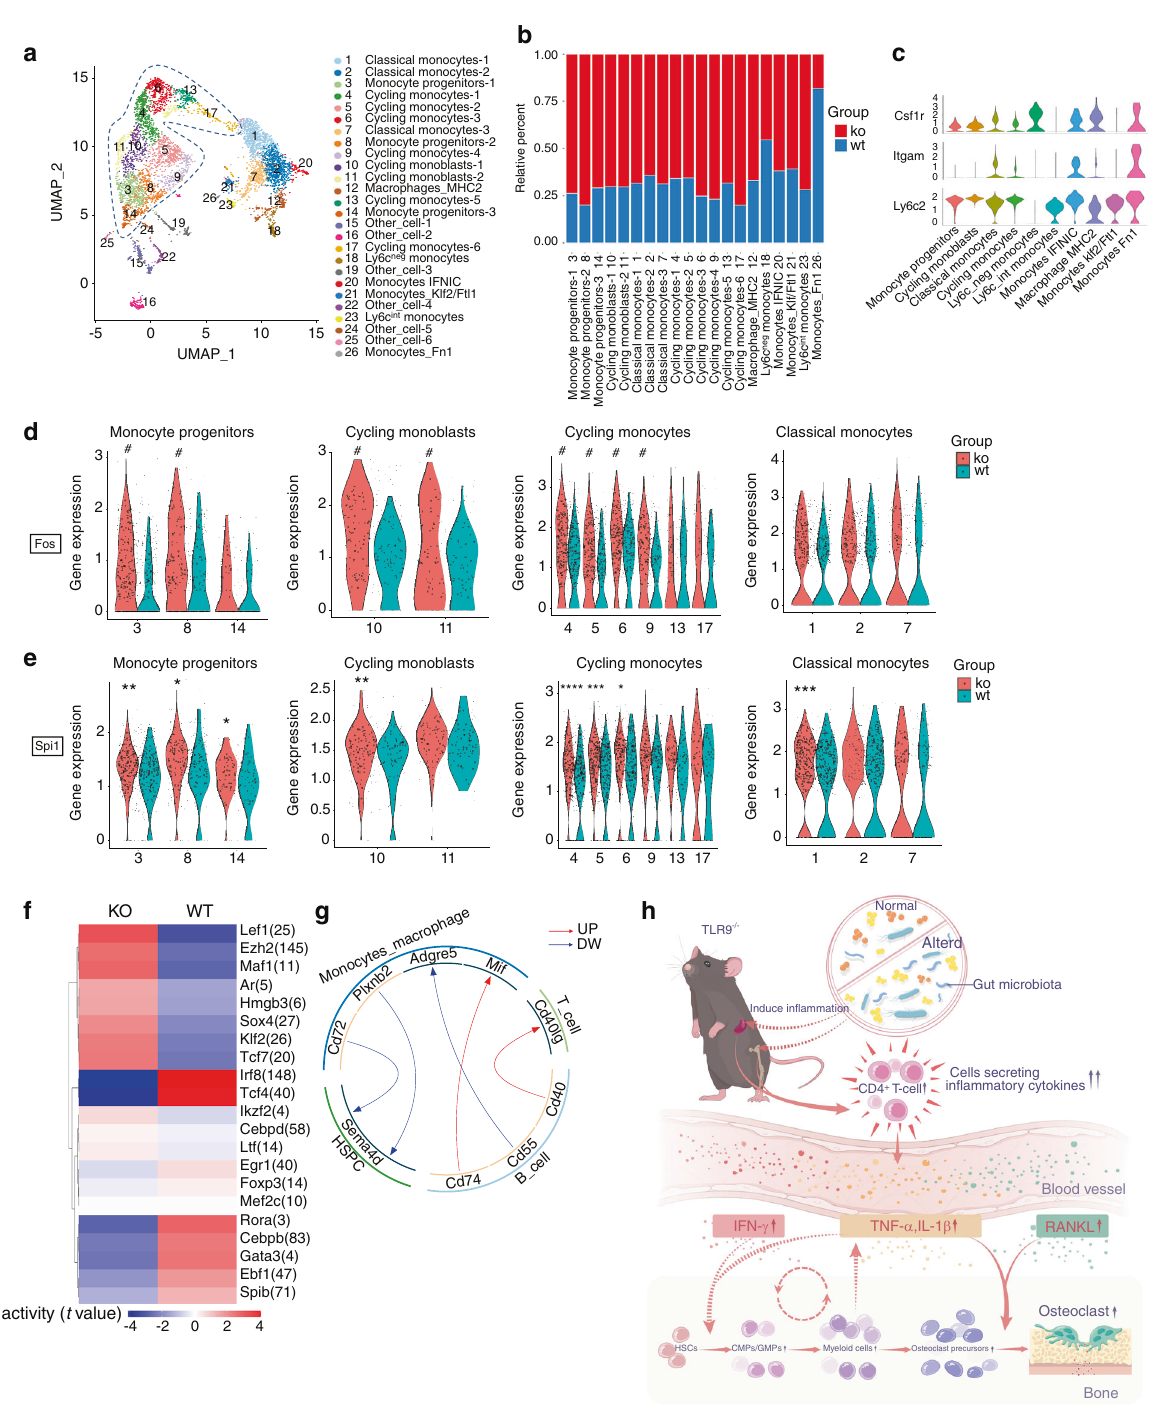
Fig. 7 scRNA-seq mapping of bone marrow monocyte/macrophages and T cells. a – e Mapping of monocyte/macrophages. a The reclustered monocyte/macrophages (pool of cluster 5, 11, 15, 21, 27 in Fig. 5a). The immature monocytes are circled with a blue dotted line. b Relative percentages of KO and WT cells in each subcluster. X axis represents cluster number and cell type. c Expression of OCP markers in different cell types. Clusters of the same cell types in a were combined for analysis. d , e Differences of Fos ( d ) and Spi1 ( e ) expression between KO and WT cells in the indicated subclusters. X axis represents subcluster numbers. In d , the pound sign means signi fi cant difference in average expression of Fos with P < 0.05 and fold change> 1.5. f , g . Analysis of bone marrow T cells. f SCENIC analysis reveals differences of the regulon activities between TLR9 − / − (KO) and wildtype (WT) cells in total T cells. g Ligand-receptor predictions among indicated cell types. Red and blue arrows show the upregulated and downregulated ligand-receptor pairs in KO cells, respectively. h Proposed model for the mechanism of osteoclastic bone loss in TLR9 − / − mice. The TLR9 − / − mice exhibit a low-grade systemic in fl ammation derived from the altered gut microbiota. The systemic in fl ammation features expansion of CD4 + T cells and increased in fl ammatory cytokines. These cytokines not only stimulate OCPs to differentiate into osteoclasts, but also increase the pool of OCPs by promoting the myeloid-biased hematopoiesis. The dual effect of the in fl ammatory cytokines signi fi cantly promote osteoclastogenesis and bone loss in TLR9 − / − mice. Furthermore, increased myeloid cells may also contribute to the maintenance of the chronicity of in fl ammation, resulting in a feed-forward loop. In d and e , the asterisks mean signi fi cant difference in average gene expression. Wilcoxon test was used to determine the signi fi cance in d and e . * P < 0.05, ** P < 0.01, *** P < 0.001 and **** P <